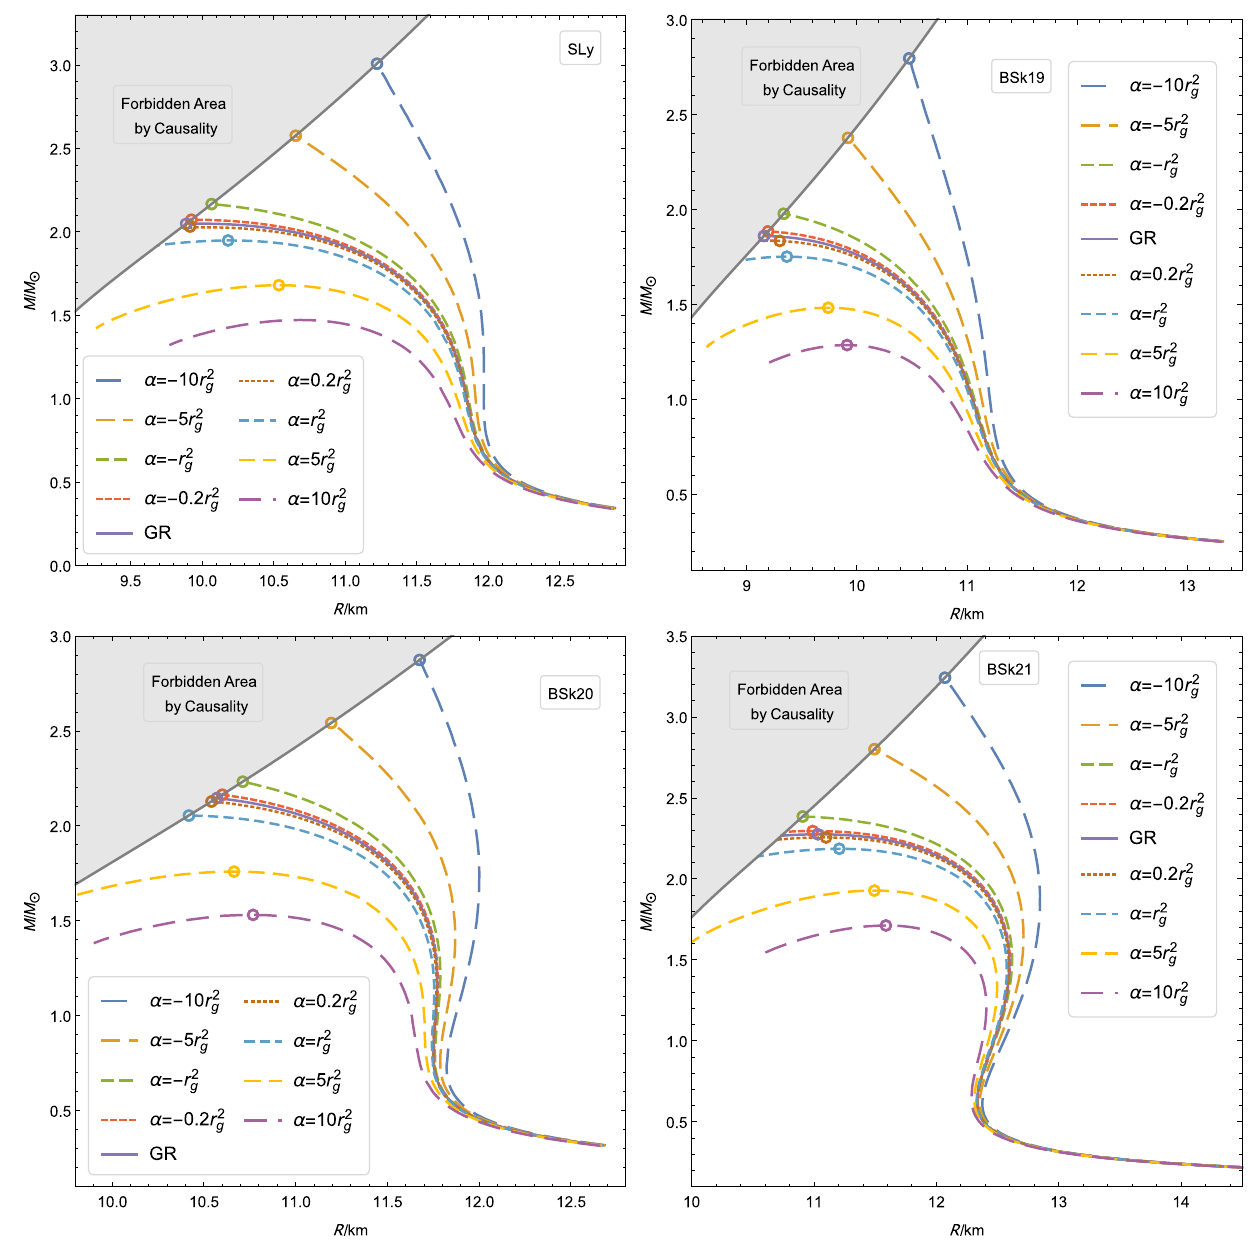
Fig. 6 Mass–radius curves for SLy, BSk19, BSk20, and BSk21 EOSs, considering various representative values of α . The curve corresponding to GR is recovered when α =